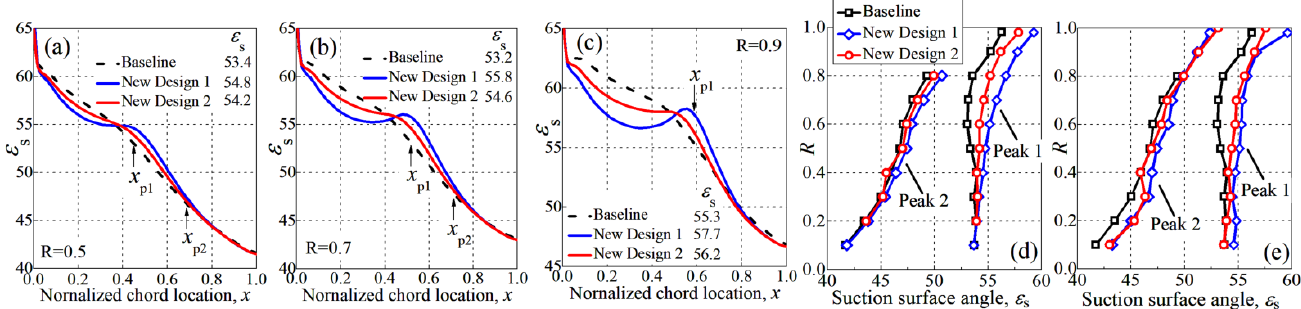
Figure 7. The suction surface angle distribution (cid:2013) at relative blade height (cid:1844) = 0.5,0.7 and 0.9 ( a – c ); the suction surface angle (cid:2013) (cid:2903) at baseline design peak Mach number location ( d ) and corresponding peak Mach number location ( e ).